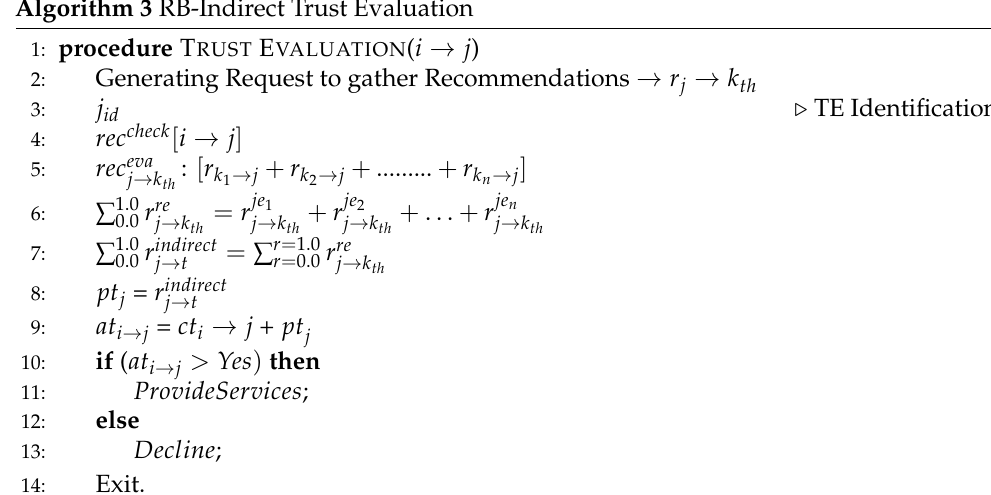
Algorithm 3 RB-Indirect Trust